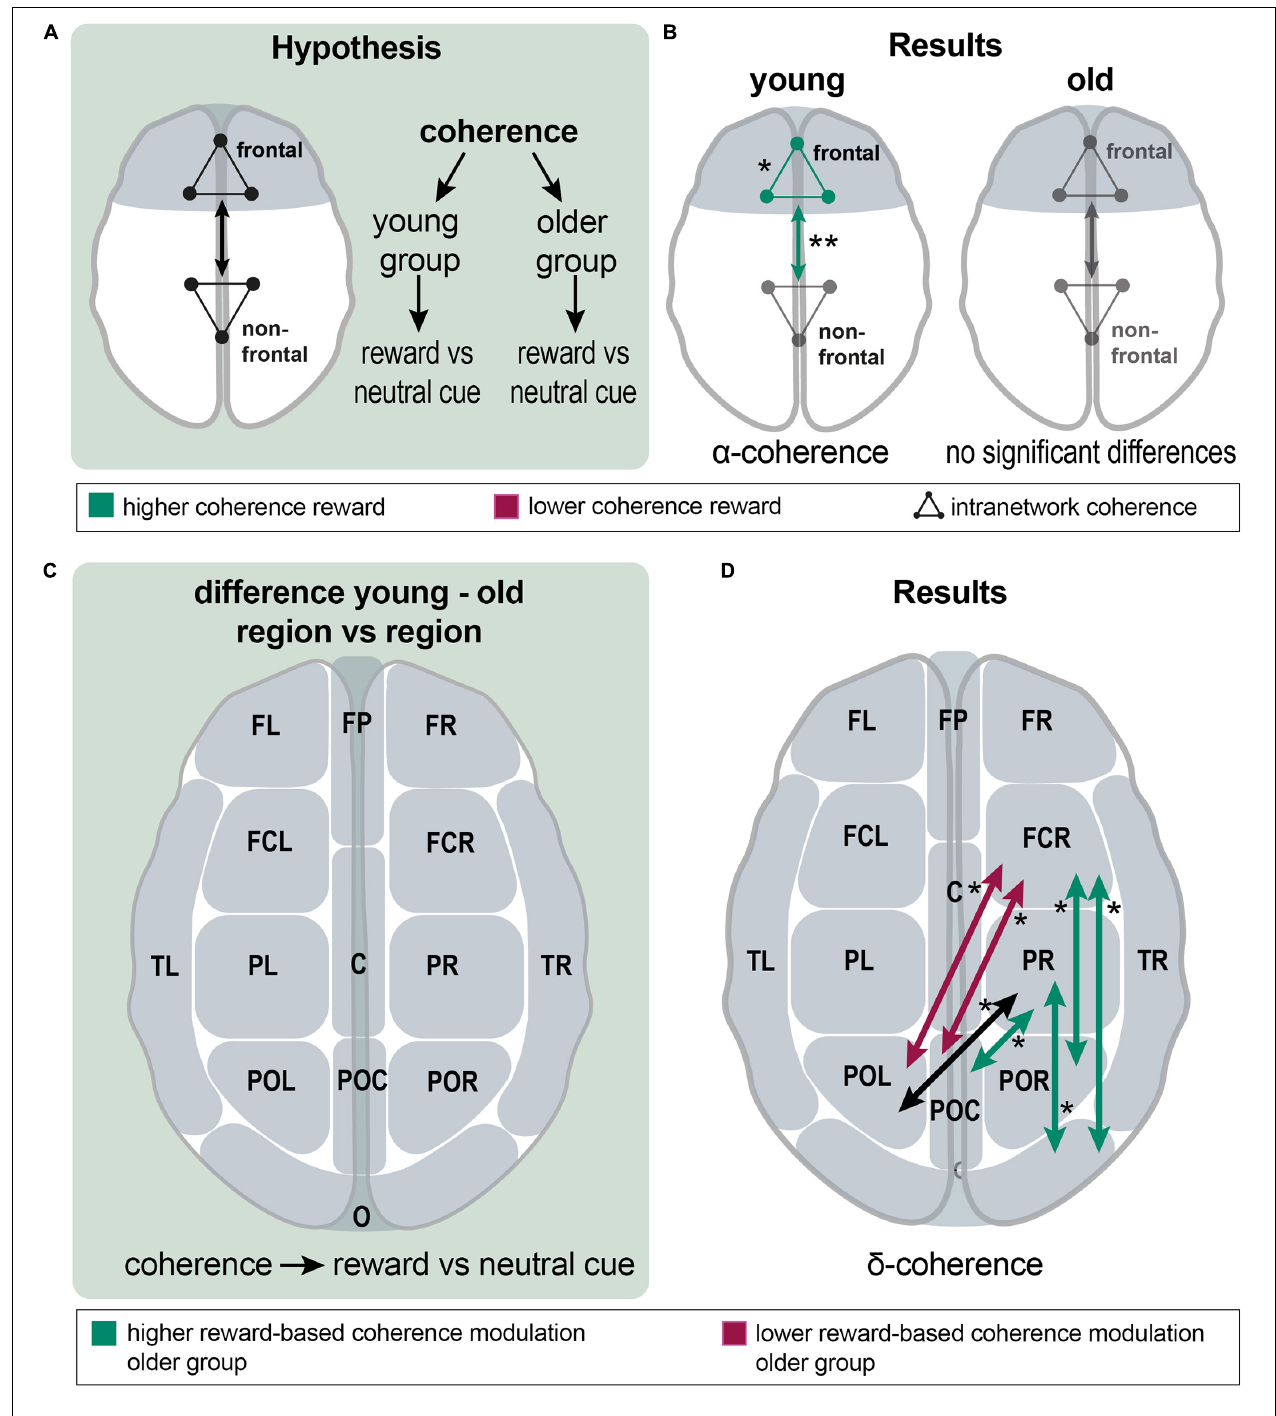
FIGURE 4 | Analysis of reward effects on frontal intra- and internetwork connectivity and of group differences in reward effect on interregional connectivity; (A), a schematic overview over the analyzing procedure: Within-group coherence was analyzed for the reward vs. neutral cue contrast between frontal and non-frontal EEG channel groups. (B), Results show a higher frontal network and higher frontal-nonfrontal alpha-band coherence during the reward cue. There were no significant differences in the older group. (C), A schematic overview of the analyzing procedure: Between group comparison of interregional coherence for the reward vs. neutral cue contrast. (D), Results: significant differences appeared in the delta band; reward-based modulation was higher in the older group for frontocentral right and parietal right with parietooccipital and occipital channel groups. In detail, this applied to FCR with POR and O; and PR with POC and O (green arrows). Modulation was higher in the younger group for FCR with POL and POC (red arrows). Coherence was significantly different between PR and POL; both groups modulated it in the same absolute value, but in different directions (a black arrow). Asterisks: one asterisk: p ≤ 0.05; two asterisks: p ≤ 0.01.